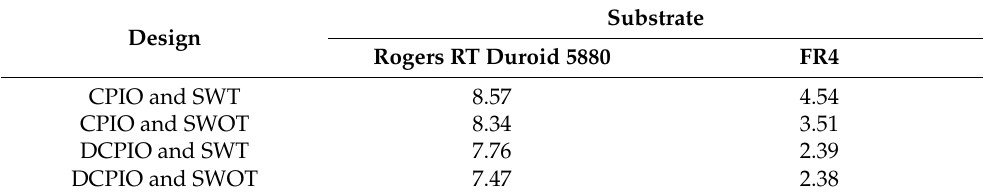
Figure 12. Total gain for the presented four antenna structures by selecting the substrate Rogers RT Duroid 5880. ( a ) 8.57 dB for the CPIO and SWT ( b ) 8.34 dB for the CPIO and SWOT ( c ) 7.76 dB for the DCPIO and SWT ( d ) 7.7 dB for the DCPIO and SWOT. Table 4. Total gain for the two different substrates, Rogers RT Duroid 5880 and